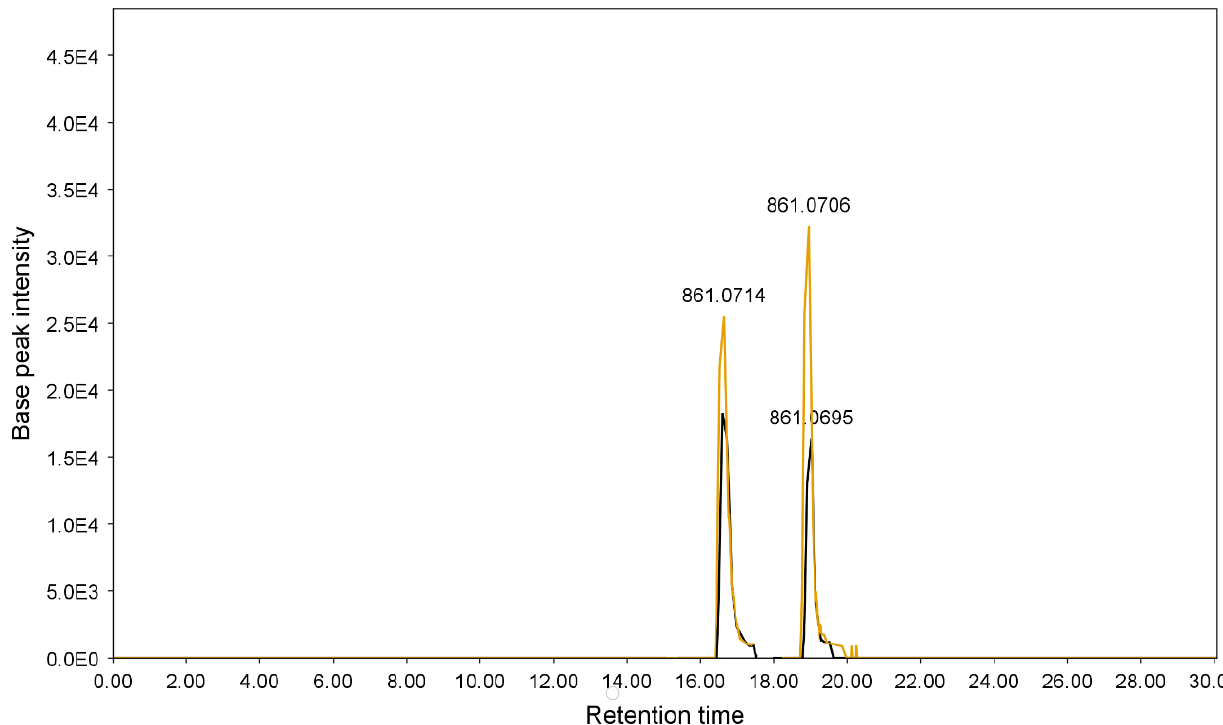
Figure 8. Extracted ion chromatograms (XICs) of sennosides A and B for S. italica (black) and S. alexandrina (orange) 100% MeOH extracts. ESIMS: extracted ion chromatograms (XIC), negative ion mode, m / z 861.000–862.0000. E5: 10 5 , E6: 10 6 . (For interpretation of the references to color in this figure legend, the reader is referred to the web version of this article.)